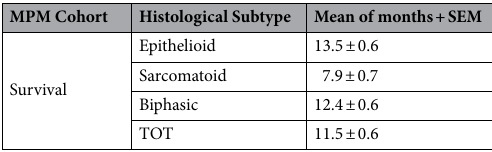
Table 2. Survival data at 18 months for MPM